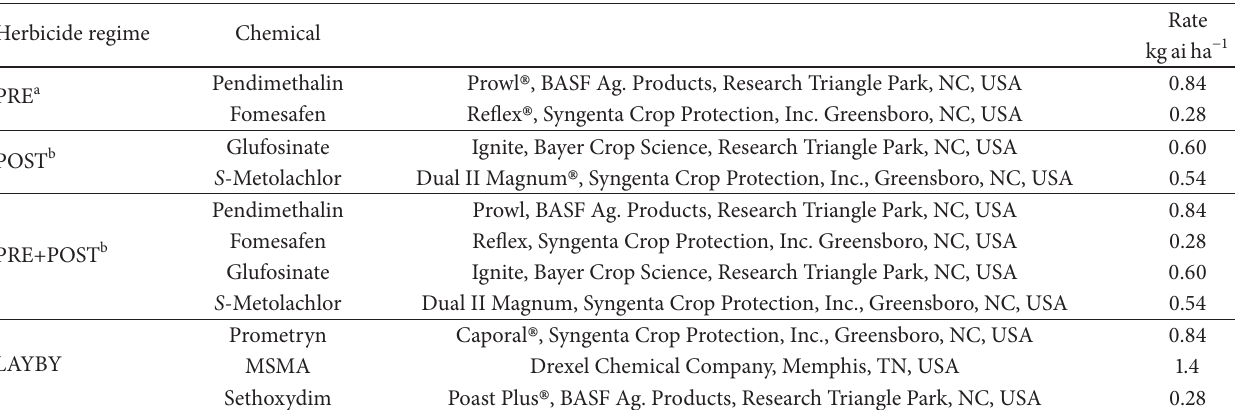
Table 2: Description of herbicide